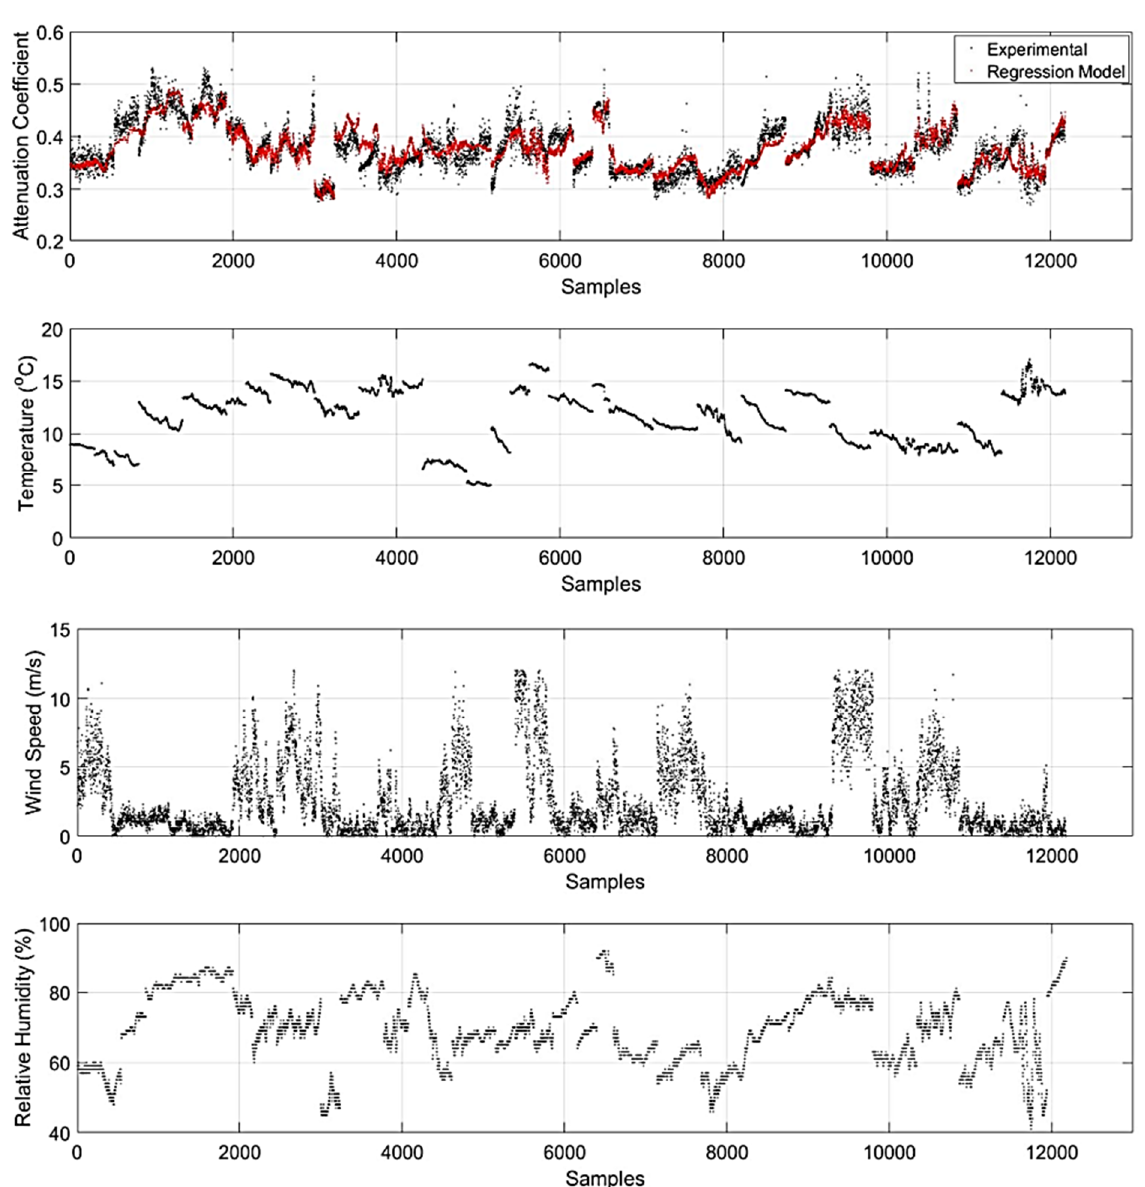
Figure 4. Measurements of temperature (second from the top panel), wind speed (third from the top panel), and relative humidity (lower panel), for each sample of regression model and experimental data.